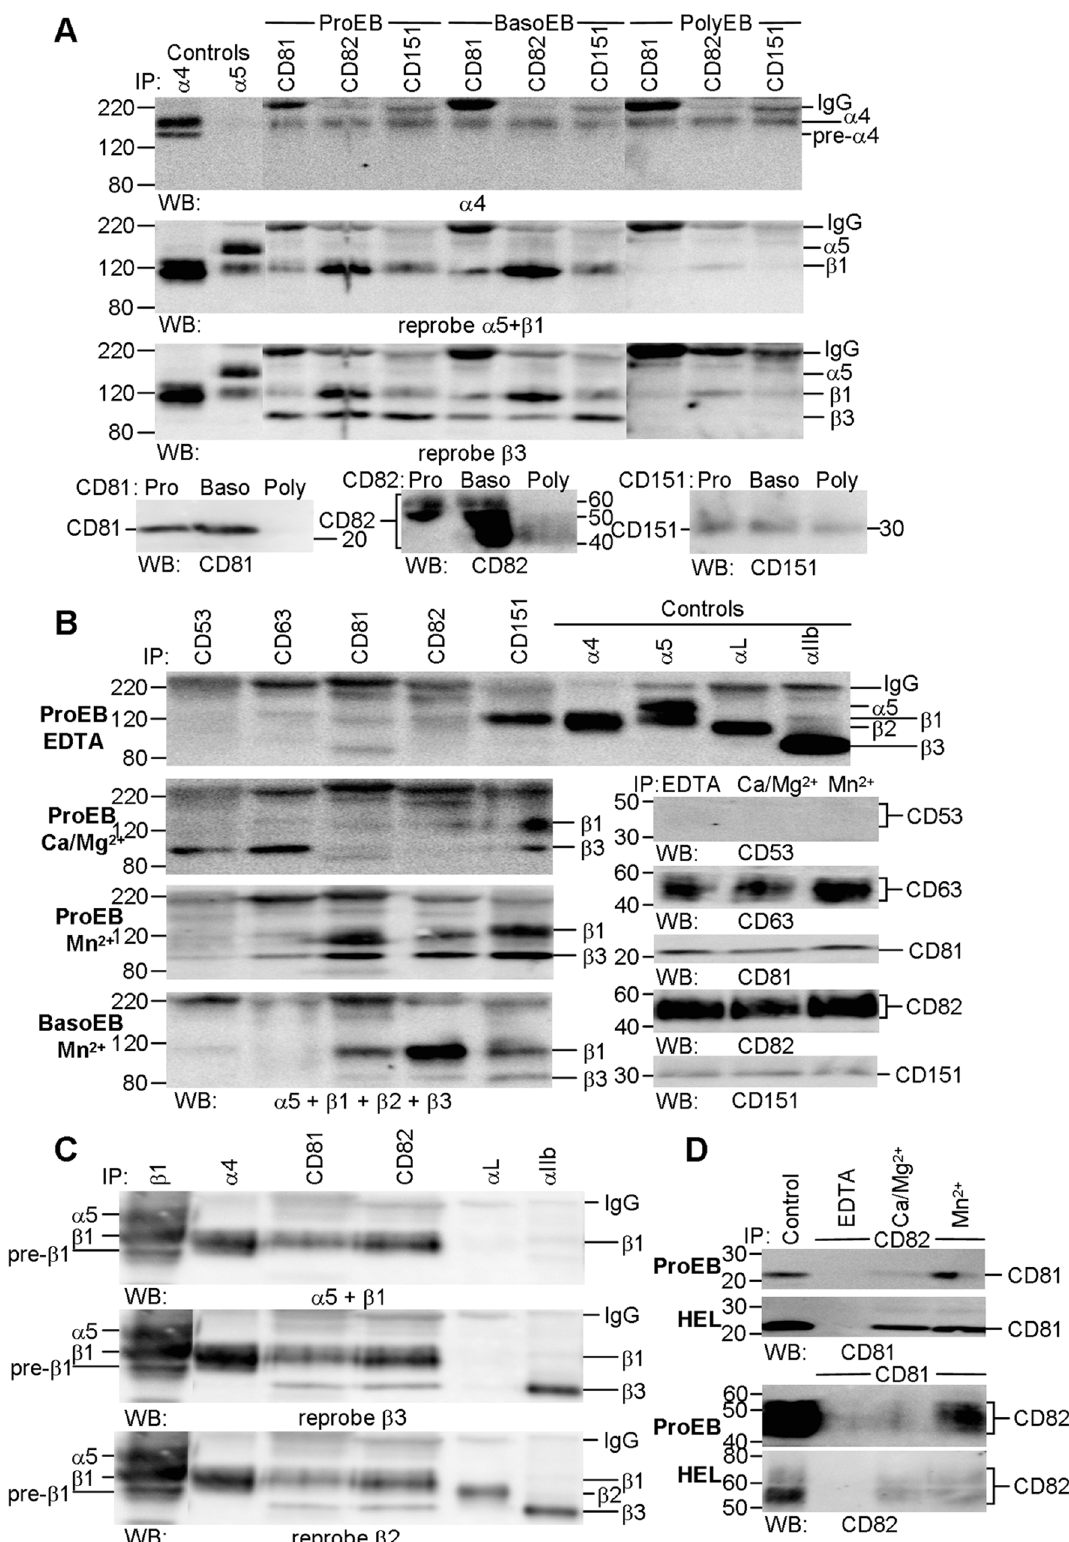
Figure 4. Tetraspanins CD81, CD82 and CD151 are associated with a 4 b 1 throughout erythroid maturation and with b 3 in proerythroblasts and basophilic erythroblasts. A. CD81, CD82 and CD151 precipitates from Mn 2 + -activated proerythroblasts (ProEB, day 5), basophilic (BasoEB, day 8) and polychromatic (PolyEB, day 12) erythroblasts were successively probed with anti- a 4, anti- b 1 and anti- b 3 antibodies; tetraspanin controls from each time point are also illustrated. All tetraspanins co-precipitated a 4 and b 1 from erythroblasts B. Tetraspanin precipitates